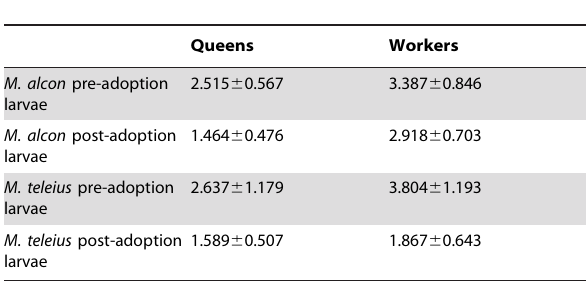
Table 1. Average Euclidean distances between sounds emitted by parasite larvae and